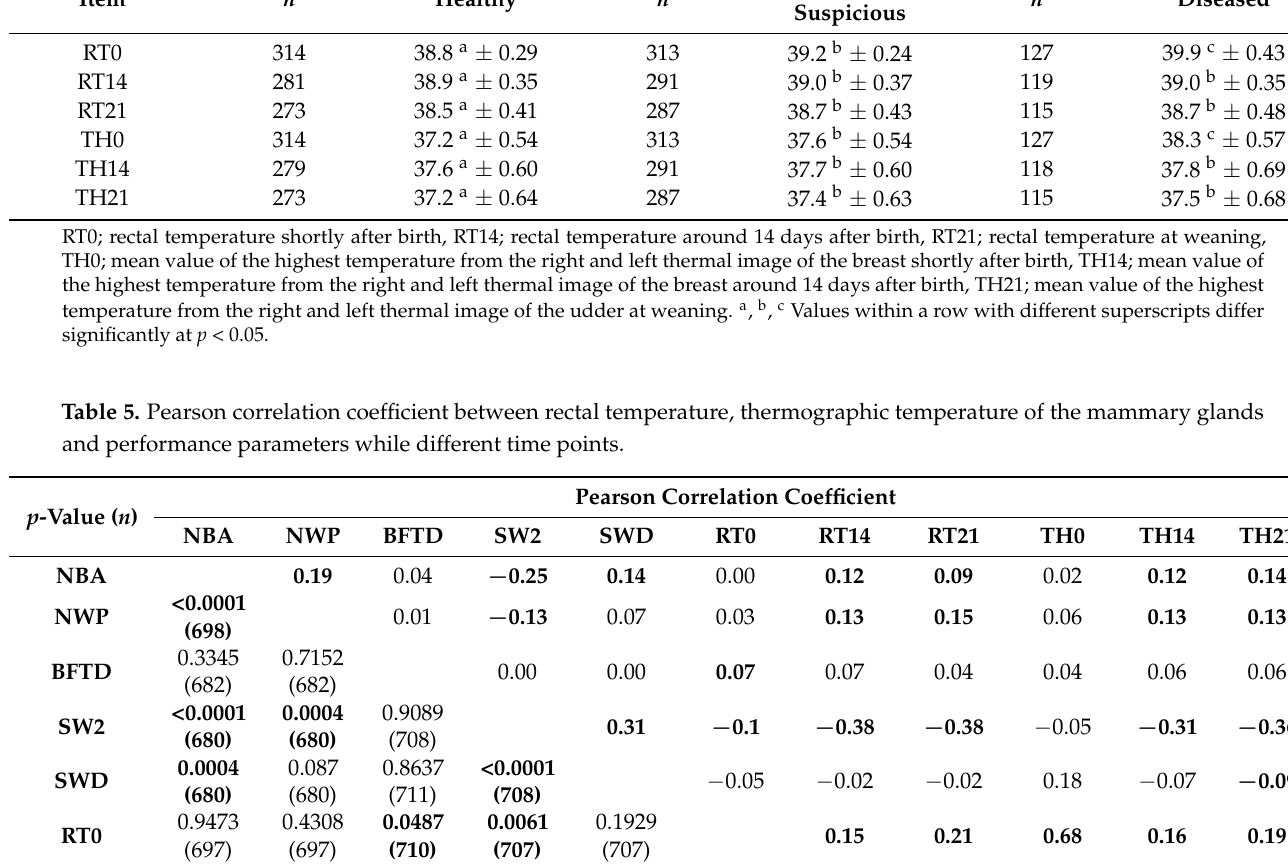
Table 4. Rectal temperature and thermographic data compared between healthy, clinically suspicious and diseased sows. Item